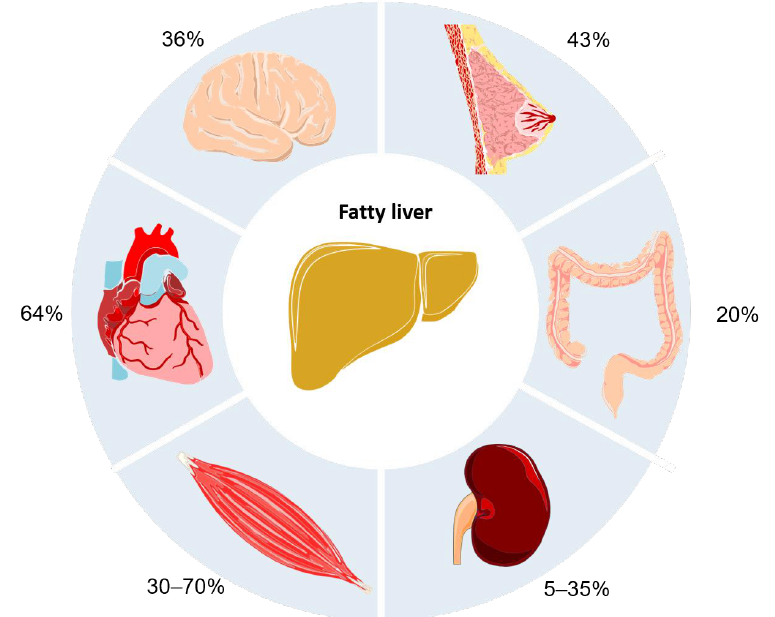
Figure 2. Incidence of extra-hepatic complication in non-alcoholic fatty liver